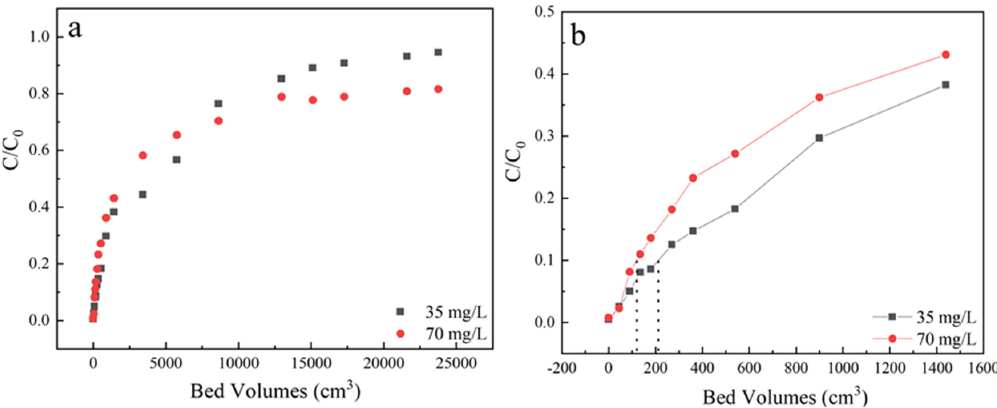
Figure 2. ( a ) The effect of different concentration of sulfamethoxazole adsorption breakthrough curves; ( b ) Partially enlarged screening from 0 to 1600 bed volume. Experiment condition: flow rate of 3 mL/min, column height of 3 cm, pH 6.5, sulfamethoxazole concentration of 35 and 70 mg/L, respectively.